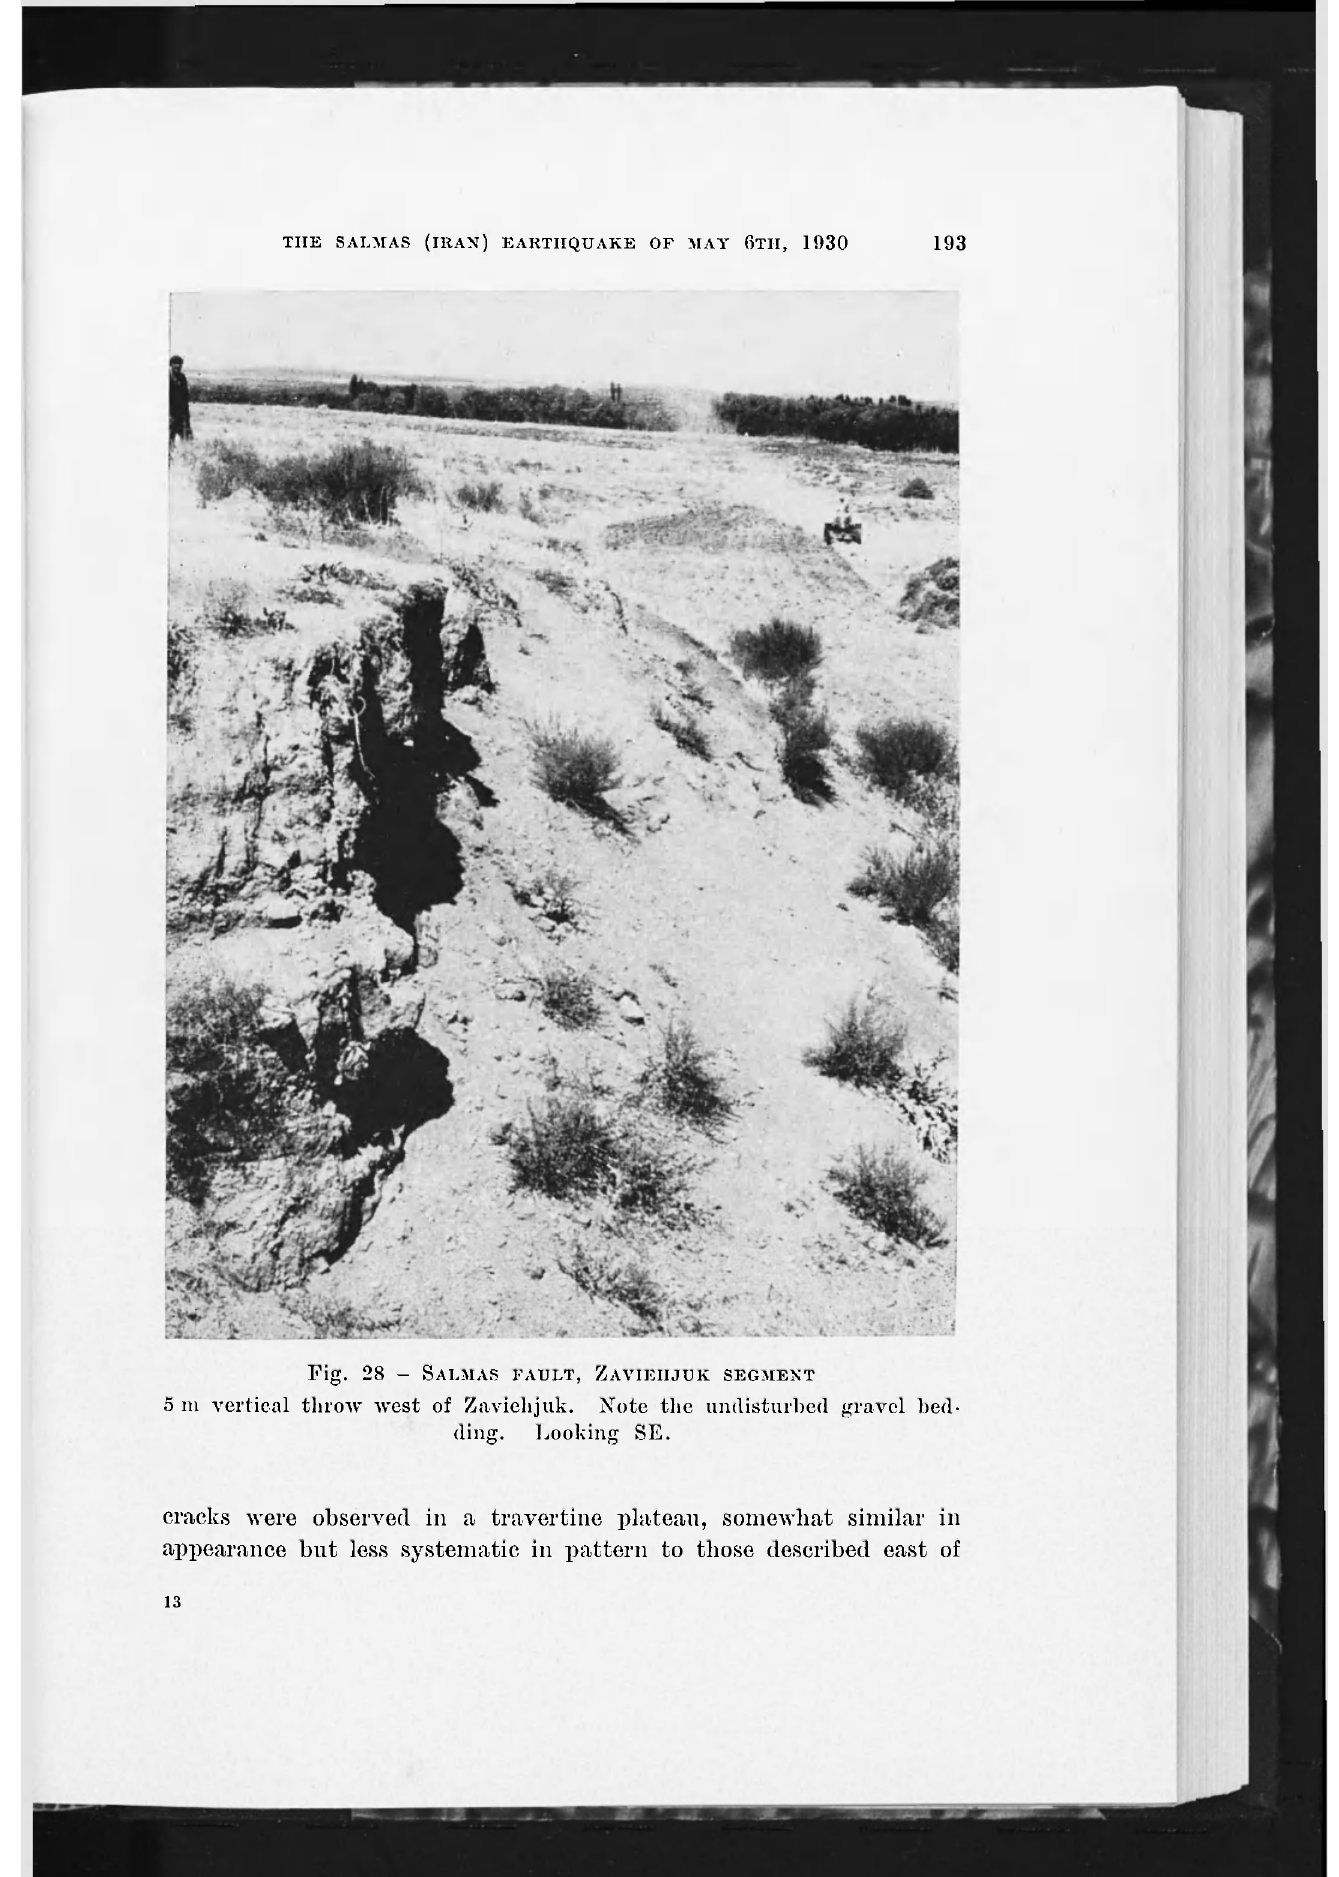
Fig. 28 - SALMAS FAULT, ZAVIEIIJUK SEGMENT 5 m vertical throw west of Zaviehjuk. Note the undisturbed gravel bed-